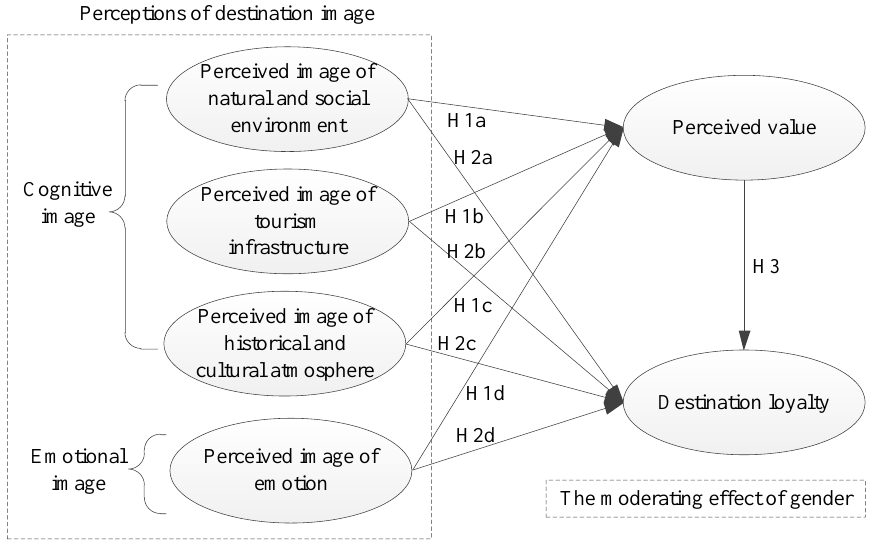
Figure 1. The conceptual framework of this study.